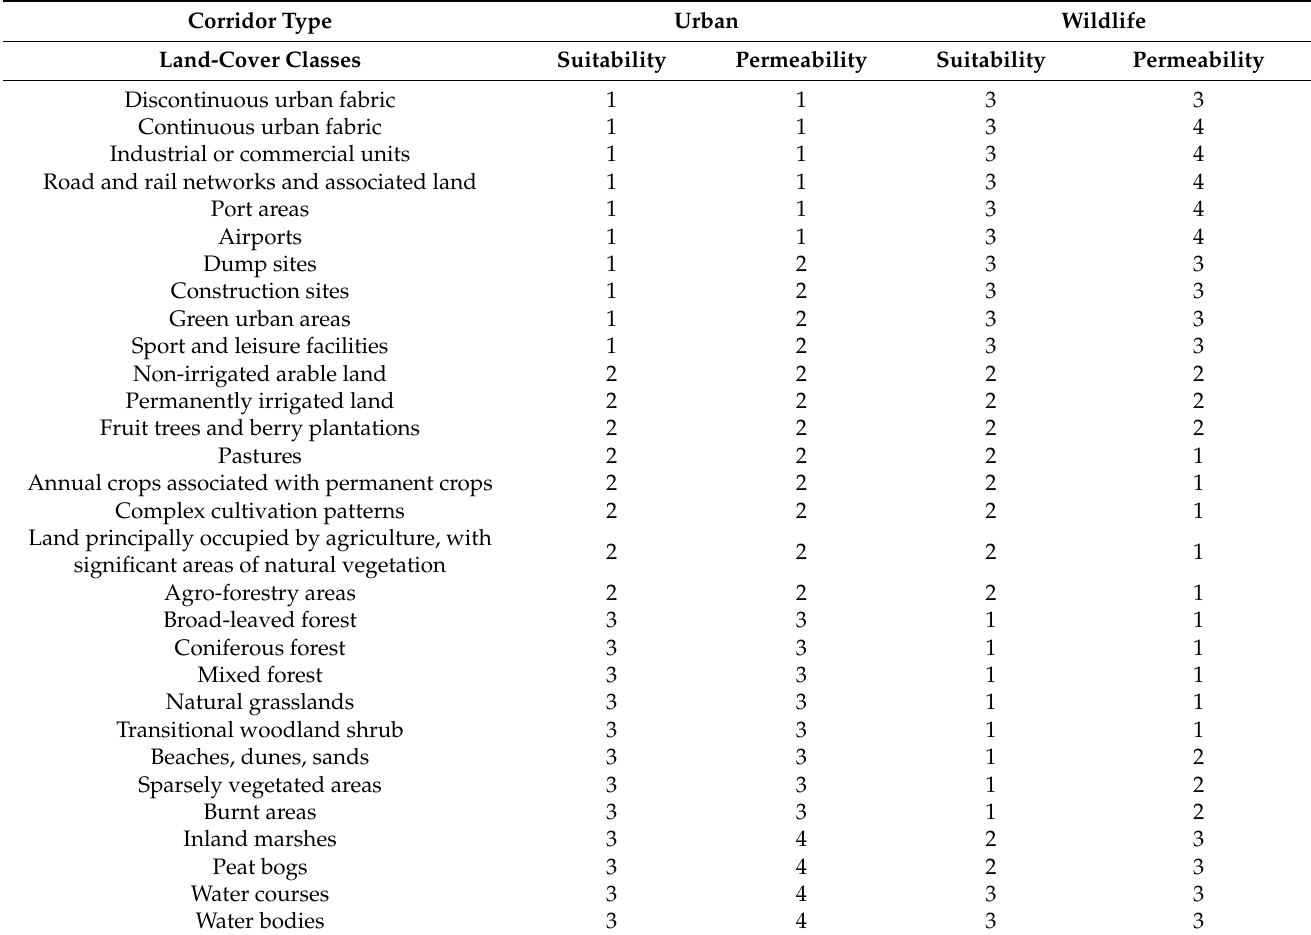
Table 2. List of land-cover/land-use suitability and the permeability scoring code list.